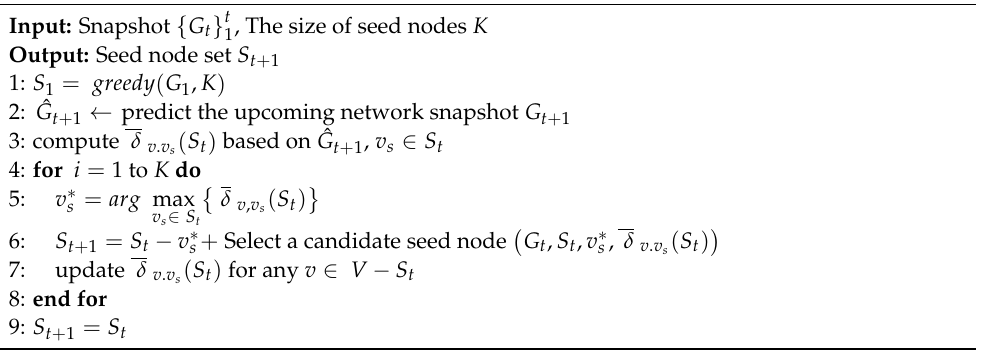
Figure 3. The flow chart of the IMPR framework. Algorithm 3 Influence maximization based on prediction and fast